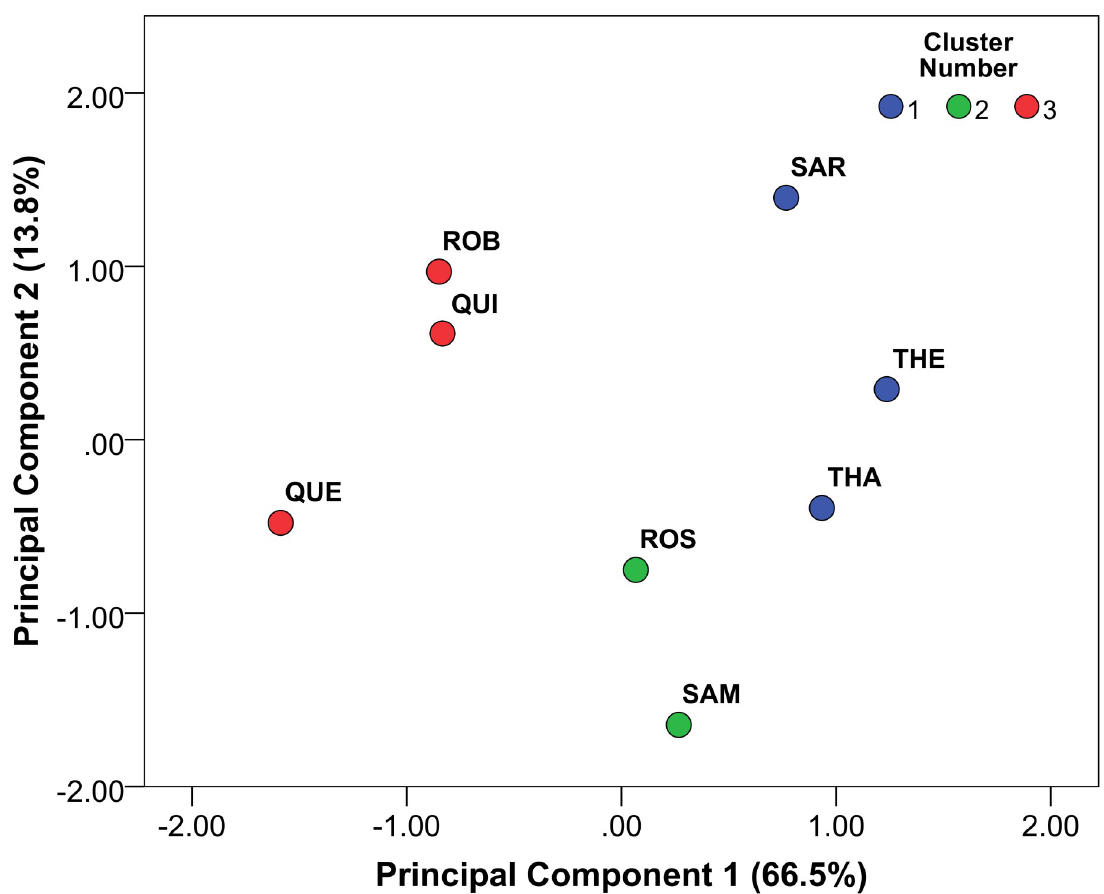
Fig 10. Results from the PCA analyses (PC1 and PC2), with individual assemblages as points labelled by their respective cluster number from the k -means cluster analysis.